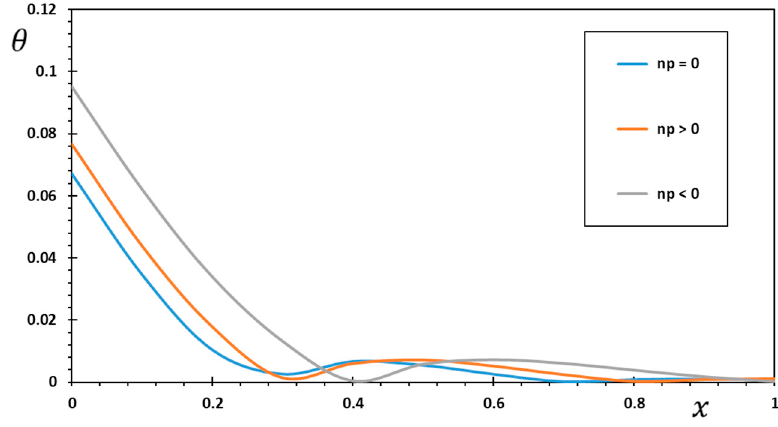
Figure 10. Effect of the gradient indicator on the dimensionless deflection, w .